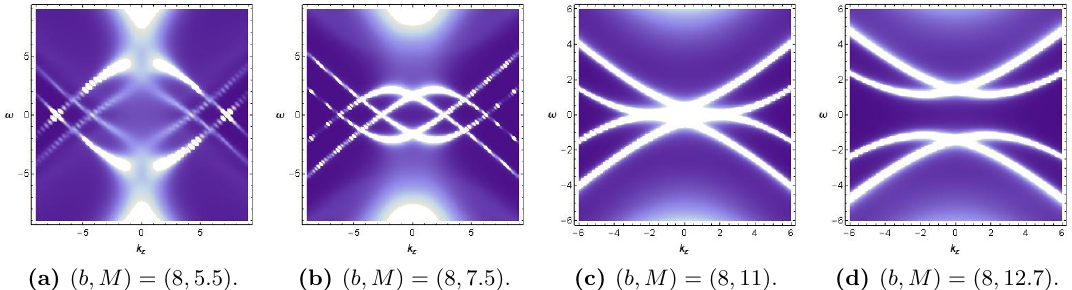
Figure 9. (a)-(d): band structure in ( k z ; ! ) with k x = k y = 0 of model in eq. (4.1). We used T = 2 =(cid:25) . Notice that at the critical point (c), it is not reduced to a Dirac point but to a higher Lifshitz point.